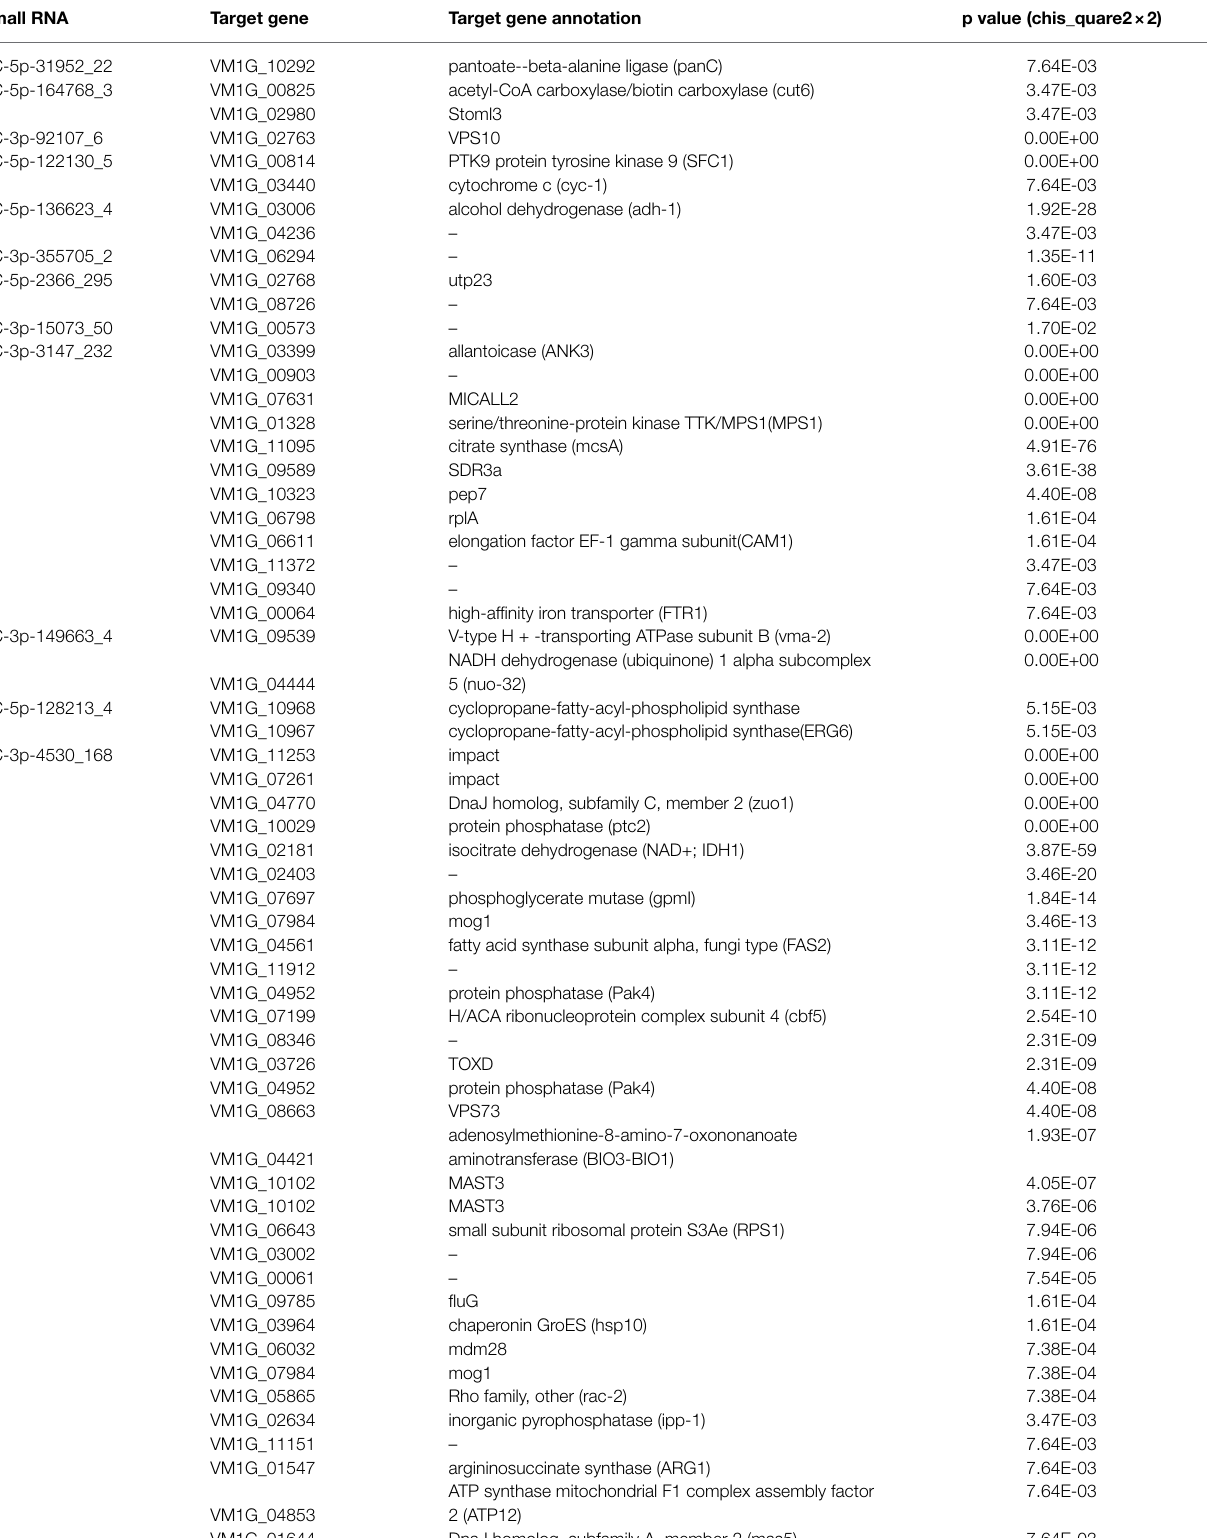
TABLE 2 | Target genes of Vm- DCL2-associated milRNAs identified by degradome sequencing. Small